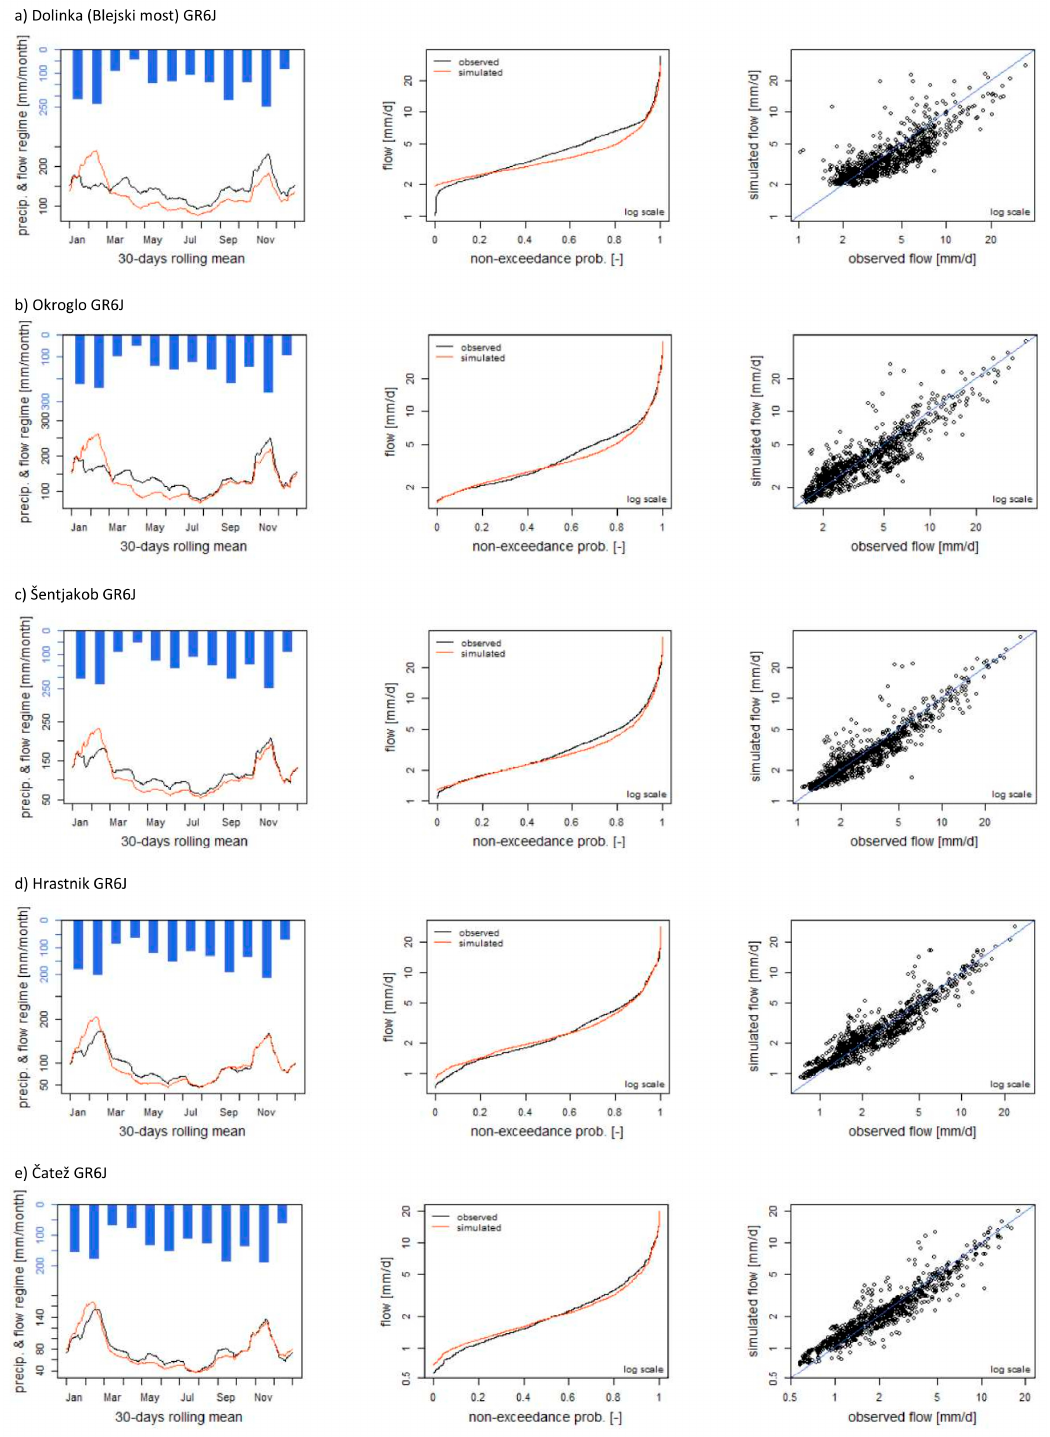
Figure 4. Evaluation of the Genie Rural 6-parameter Journalier (GR6J) model performance for the five nested sub-catchments in the validation period. 30-days rolling mean, flow duration curve, and scatter plot in log scale are shown.